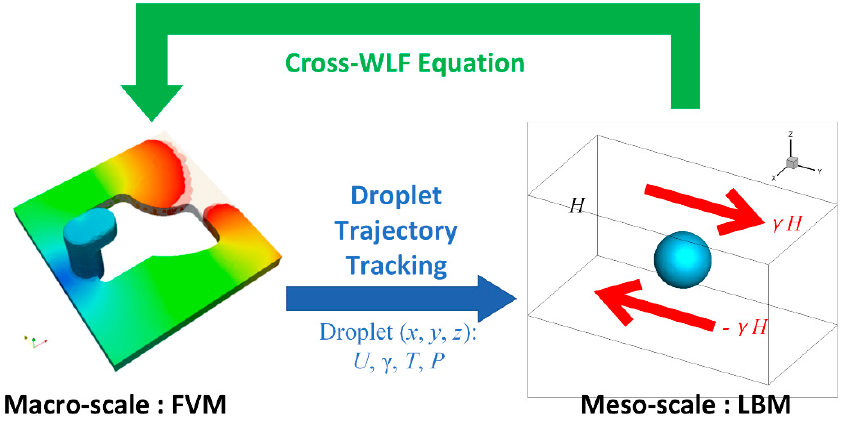
Figure 4. Coupling of macroscopic filling flow and mesoscopic morphology